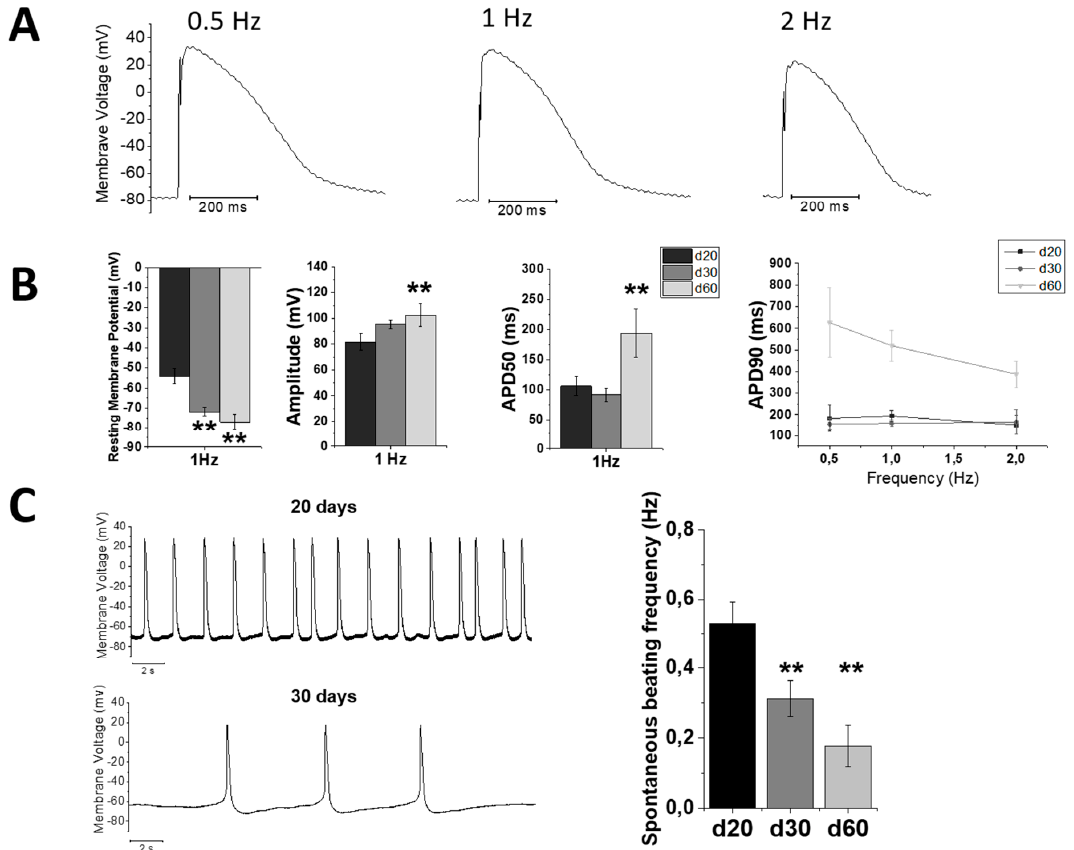
Figure 6. Action potential recording by patch clamp in earlier stages hiPSC-CMs. Earlier-stages hiPSC-CMs during patch clamp, elicited with short current pulses in current-clamp mode at day 20, 30 and 60. ( A ) Representative traces at 0.5, 1 and 2 Hz stimulation rates. ( B ) Average of resting membrane potential (mV), AP amplitude (mV), time from stimulus to 50% repolarization (APD50, ms) at 1 Hz and to 90% of repolarization (APD90, ms) with frequency variation. ( C ) Spontaneous beating frequency of action potential from day 20 to day 60. Data are reported as means ± SEM; One-way analysis of variance (ANOVA) with a Tukey post-hoc test with statistical significance set at * p < 0.05 and ** p < 0.01; NS not significant.